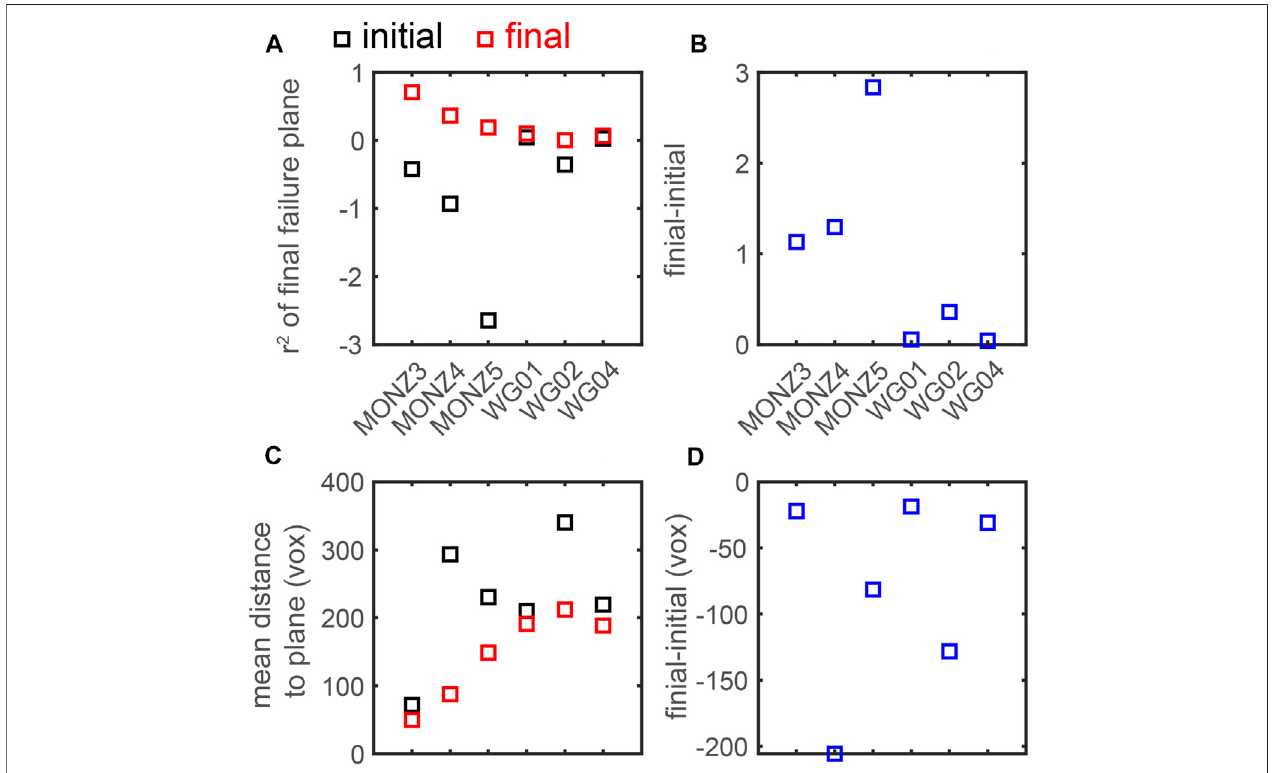
FIGURE 10 | Difference in the r 2 score (A, B) , and mean distance between the 10%largest fractures and the failure plane (C, D) from the initial and fi nal tomogram acquired in each experiment. Positive and negative changes from the initial to fi nal scan indicate increasing localization for the r 2 score and mean distance, respectively.